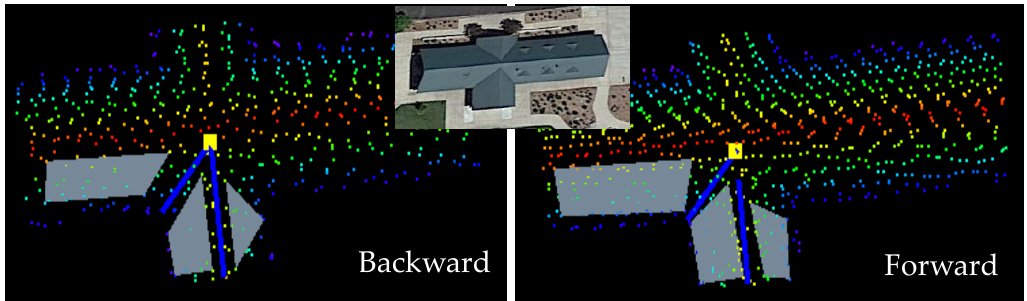
Figure 9. Three-plane pair sampled from separated point clouds due to opposite scan direction.